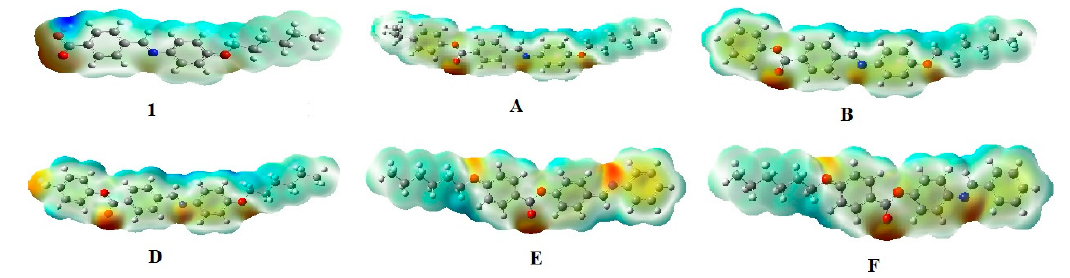
Figure 12. Electrostatic potentials (MEP) of the prepared compounds.